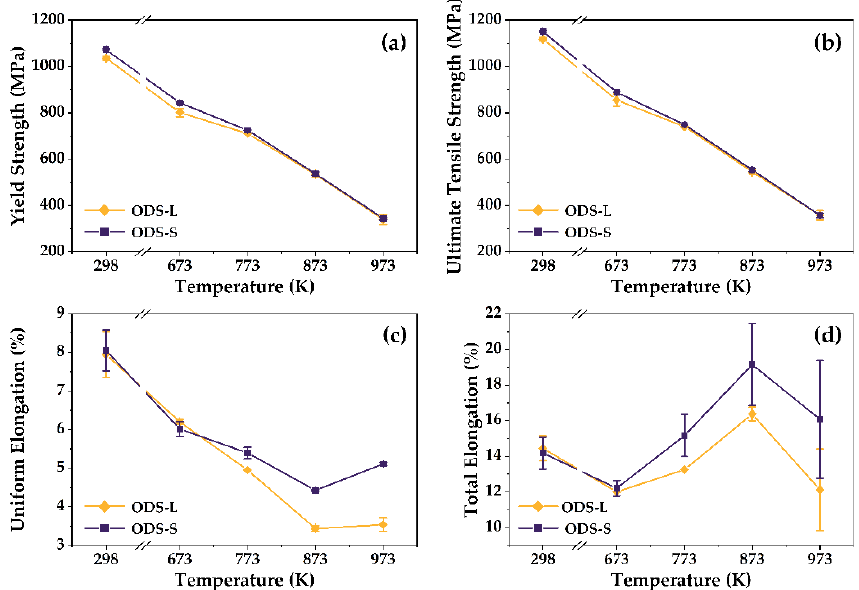
Figure 15. Mechanical properties as a function of the testing temperature for the ODS-L and ODS-S steels annealed at 1273 K after HCR on the TS plane: ( a ) Yield strength, ( b ) ultimate tensile strength, ( c ) uniform elongation, and ( d ) total elongation.